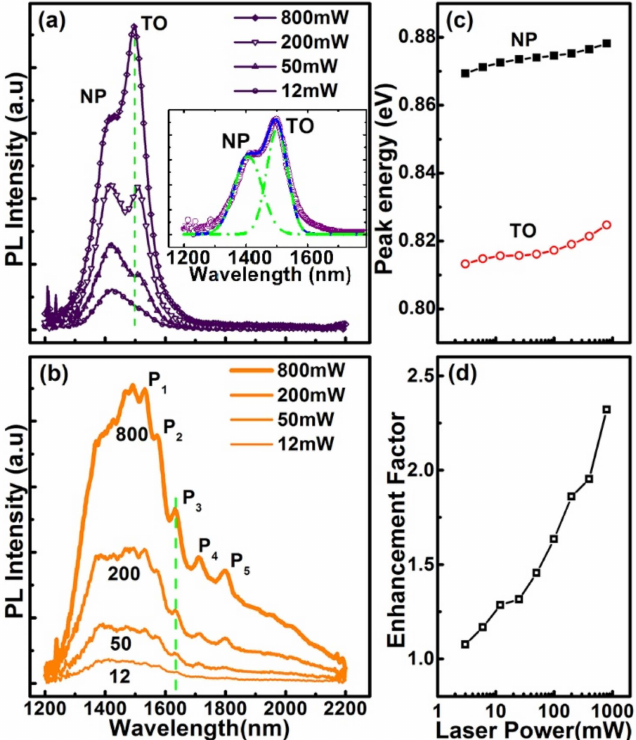
Figure 5. Power-dependent PL spectra. PL spectra of graded Ge x Si 1 − x alloys ( a ) on the flat, ( b ) on the micro-hole patterned Si(001) substrate, ( c ) energies of peaks NP and TO in ( a ) as a function of excitation power, ( d ) the enhancement factor vs. the excitation power. The inset in ( b ) shows the fitting of the PL spectrum at 800 mW by two Gaussian peaks. The dashed green line in ( a , b ) is for eye